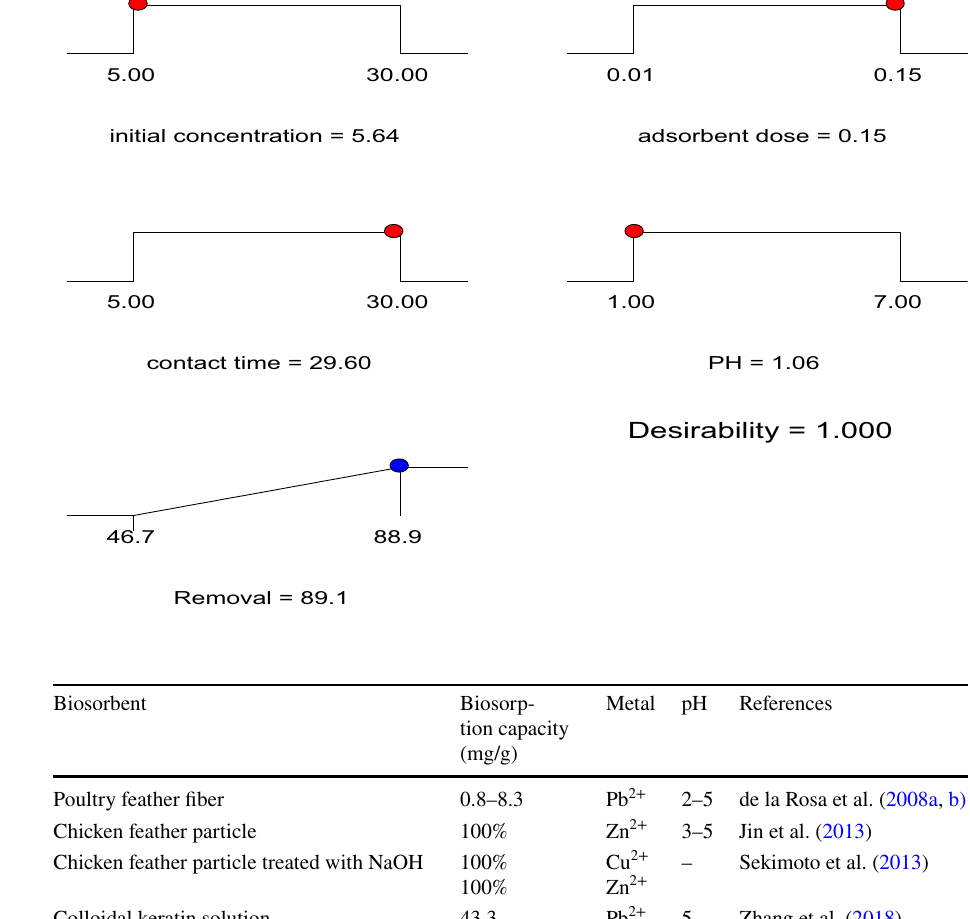
Fig. 12 Desirability ramp for numerical optimization of four selected goals